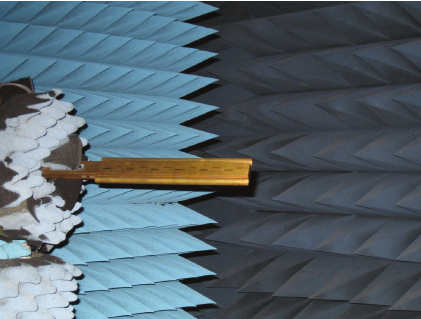
Figure 14: Photo of the X-band resonant slotted waveguide array.